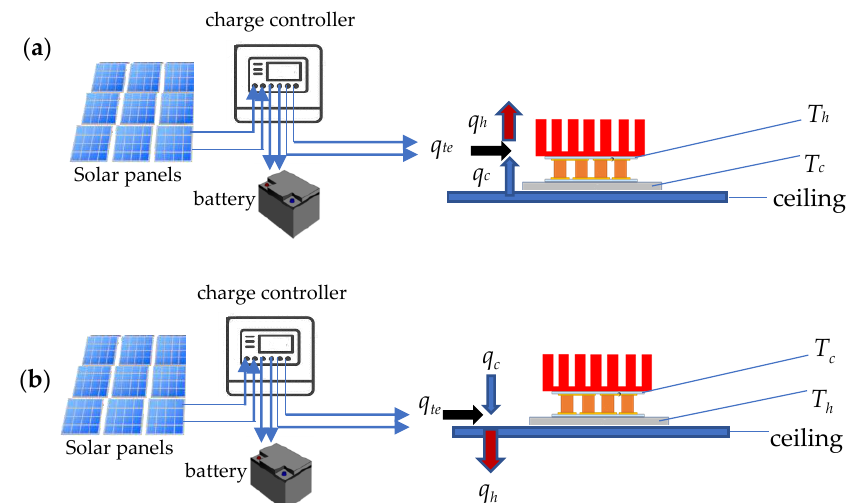
Figure 1. Schematic of the solar-powered TE-based system, ( a ) cooling (hot season); ( b ) heating (cold season).